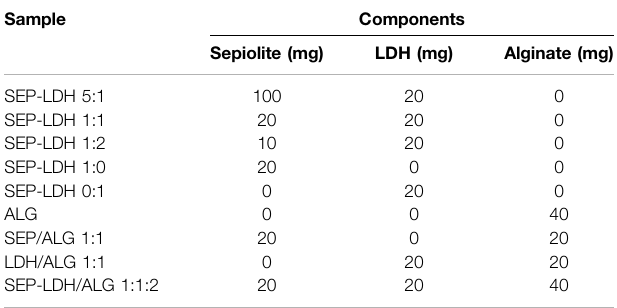
TABLE 1| Initial components in themixtures forthe preparationof SEP-LDH a and SEP-LDH/ALG b systems.